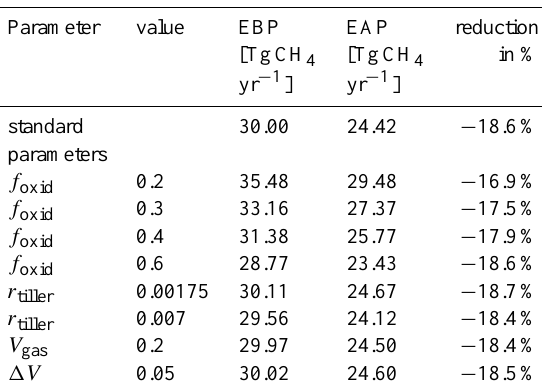
Table 1. Average methane emissions before perturbation (EBP) and after perturbation (EAP) from northern peatland; standard